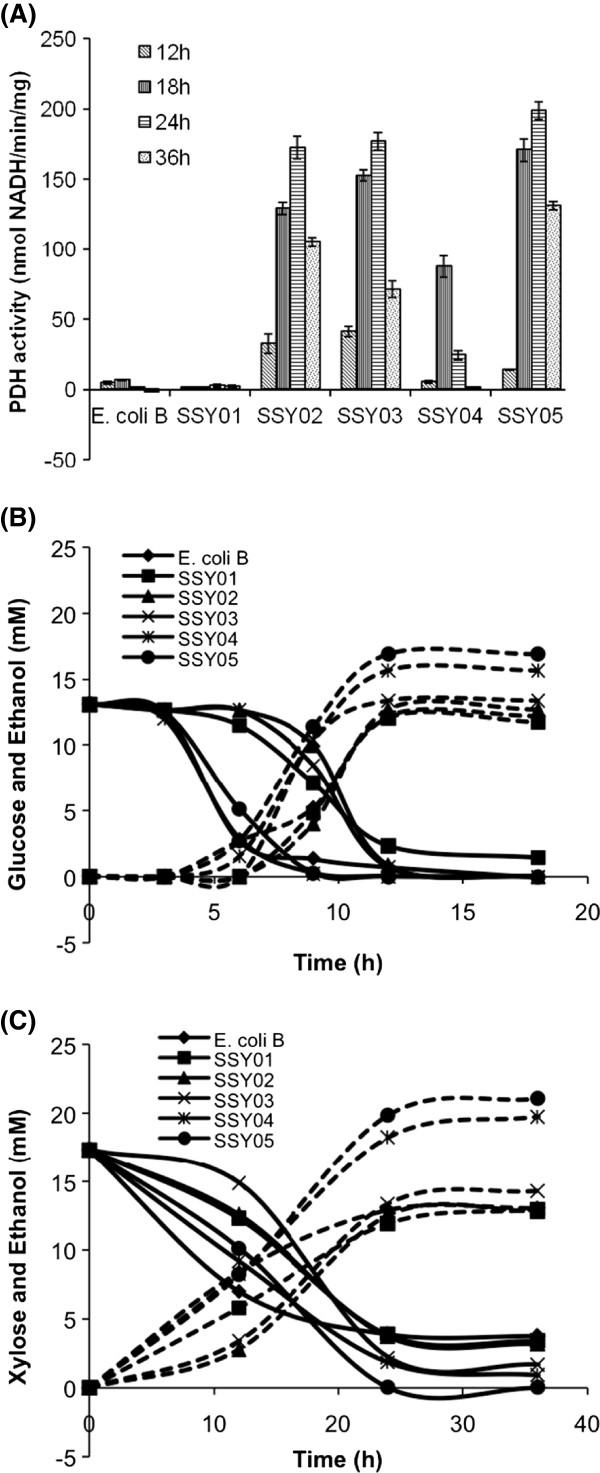
Functional characterization of promoter engineered E. coli B strains (SSY01-05, see Table1for genotype). Effect of PDH operon promoter replacement on (A) pyruvate dehydrogenase activity and (B) ethanol production was monitored. Cells were grown anaerobically in completely filled Hungate tubes and were harvested and permeabilized to measure PDH activity. The supernatant of the culture was used to analyze metabolite concentration via HPLC. Strain description for changed PDH promoter: SSY01 – PldhAPDH, SSY02 –PfrdAPDH, SSY03 – PpflBPDH, SSY04 – PadhEPDH, SSY05 – PgapAPDH.